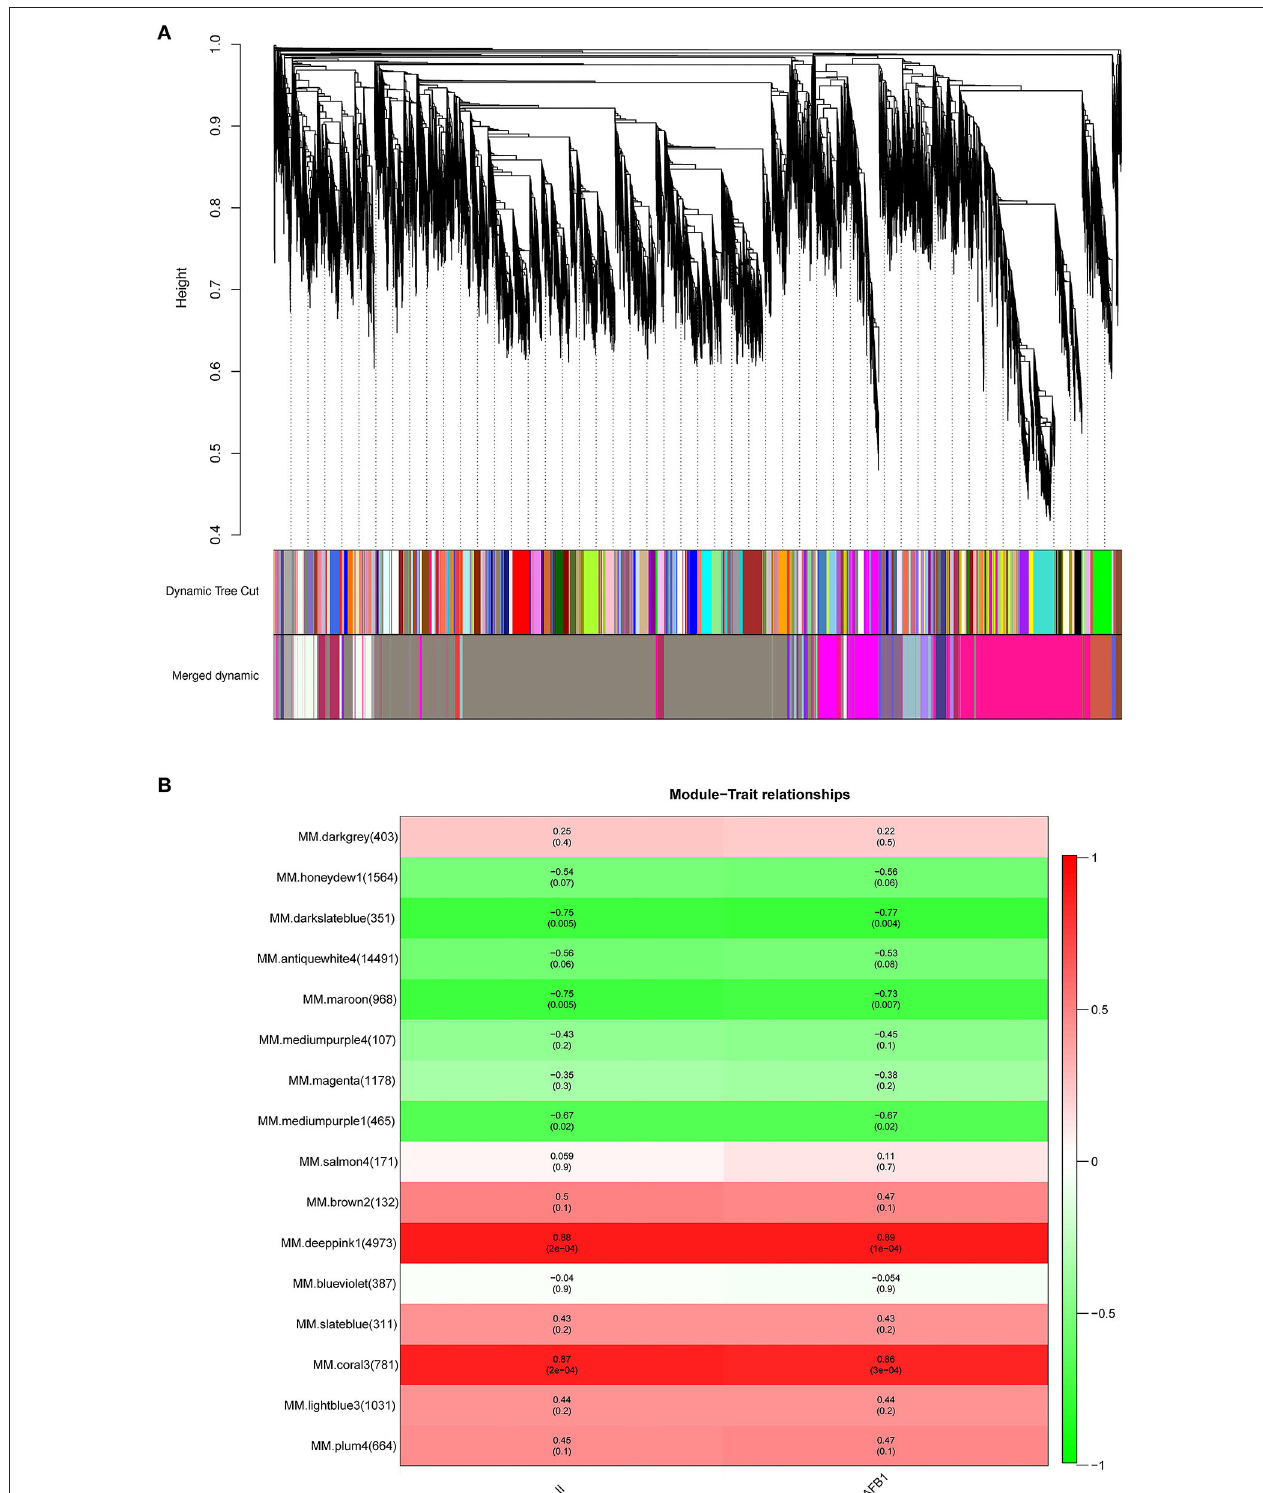
FIGURE 5 | Co-expression network analysis of DEGs and module-trait relationship (MTRs) in response to A. flavus . (A) Cluster dendrogram of different genes in co-expression modules. (B) Relationships between modules (left) and traits (bottom). The numbers in brackets on the left show the number of genes in each module. Red and green represent positive and negative correlations, respectively. The darker colors indicate higher correlation coefficients. Numbers represent Pearson’s correlation coefficients r 2 -values and the P -value for the correlation (in brackets).